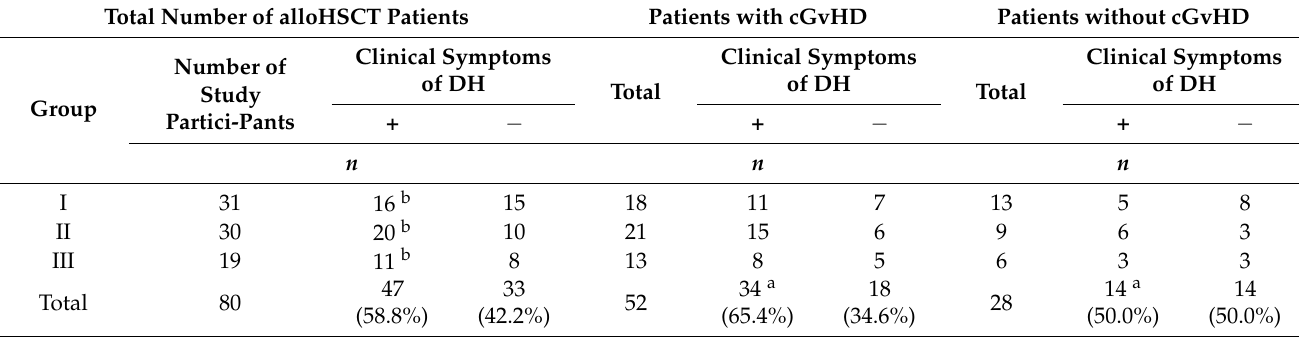
Table 3. Occurrence of dentin hypersensitivity noted during the clinical examination, taking into account the time elapsed since alloHSCT and incidence of